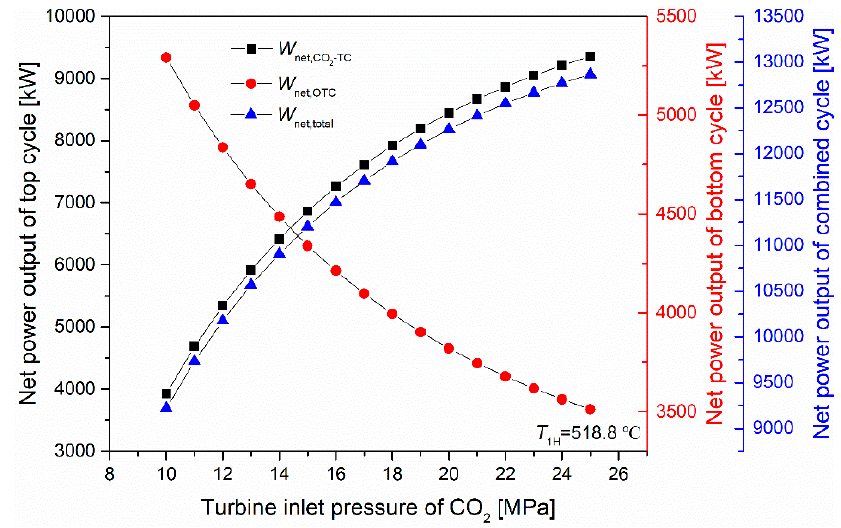
Figure 7. Variations of net power output with turbine inlet pressure of CO 2 for CO 2 -TC+OTC.